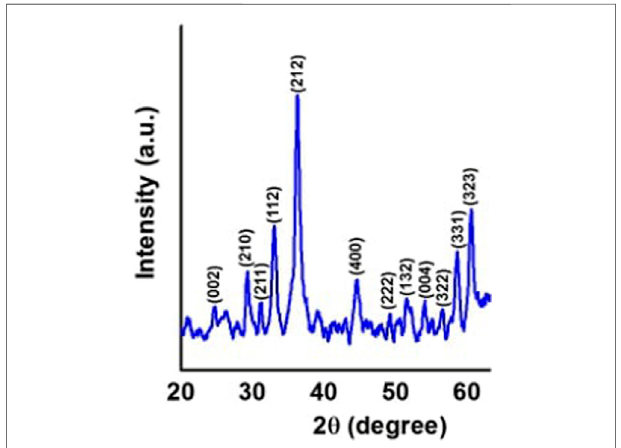
FIGURE 5 | (A) TEM; (B) HR-TEM, and (C) SAED pattern of as-prepared AC-HAp NPs.